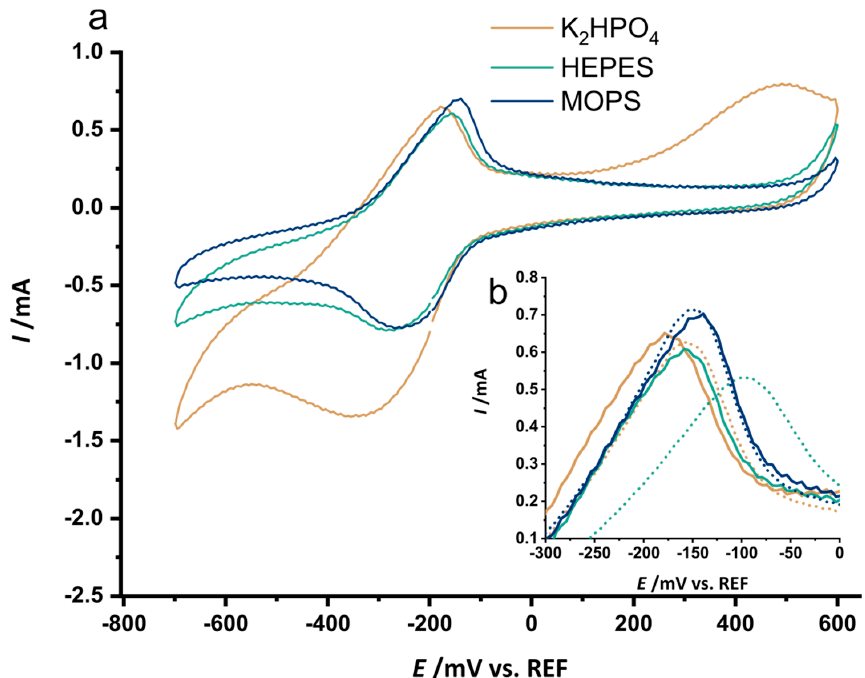
product formation is represented in ( c ).